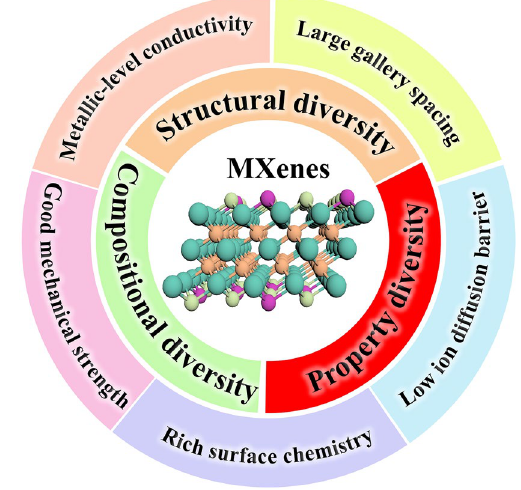
Fig. 2 Schematic illustration of the structural, compositional and property diversity of